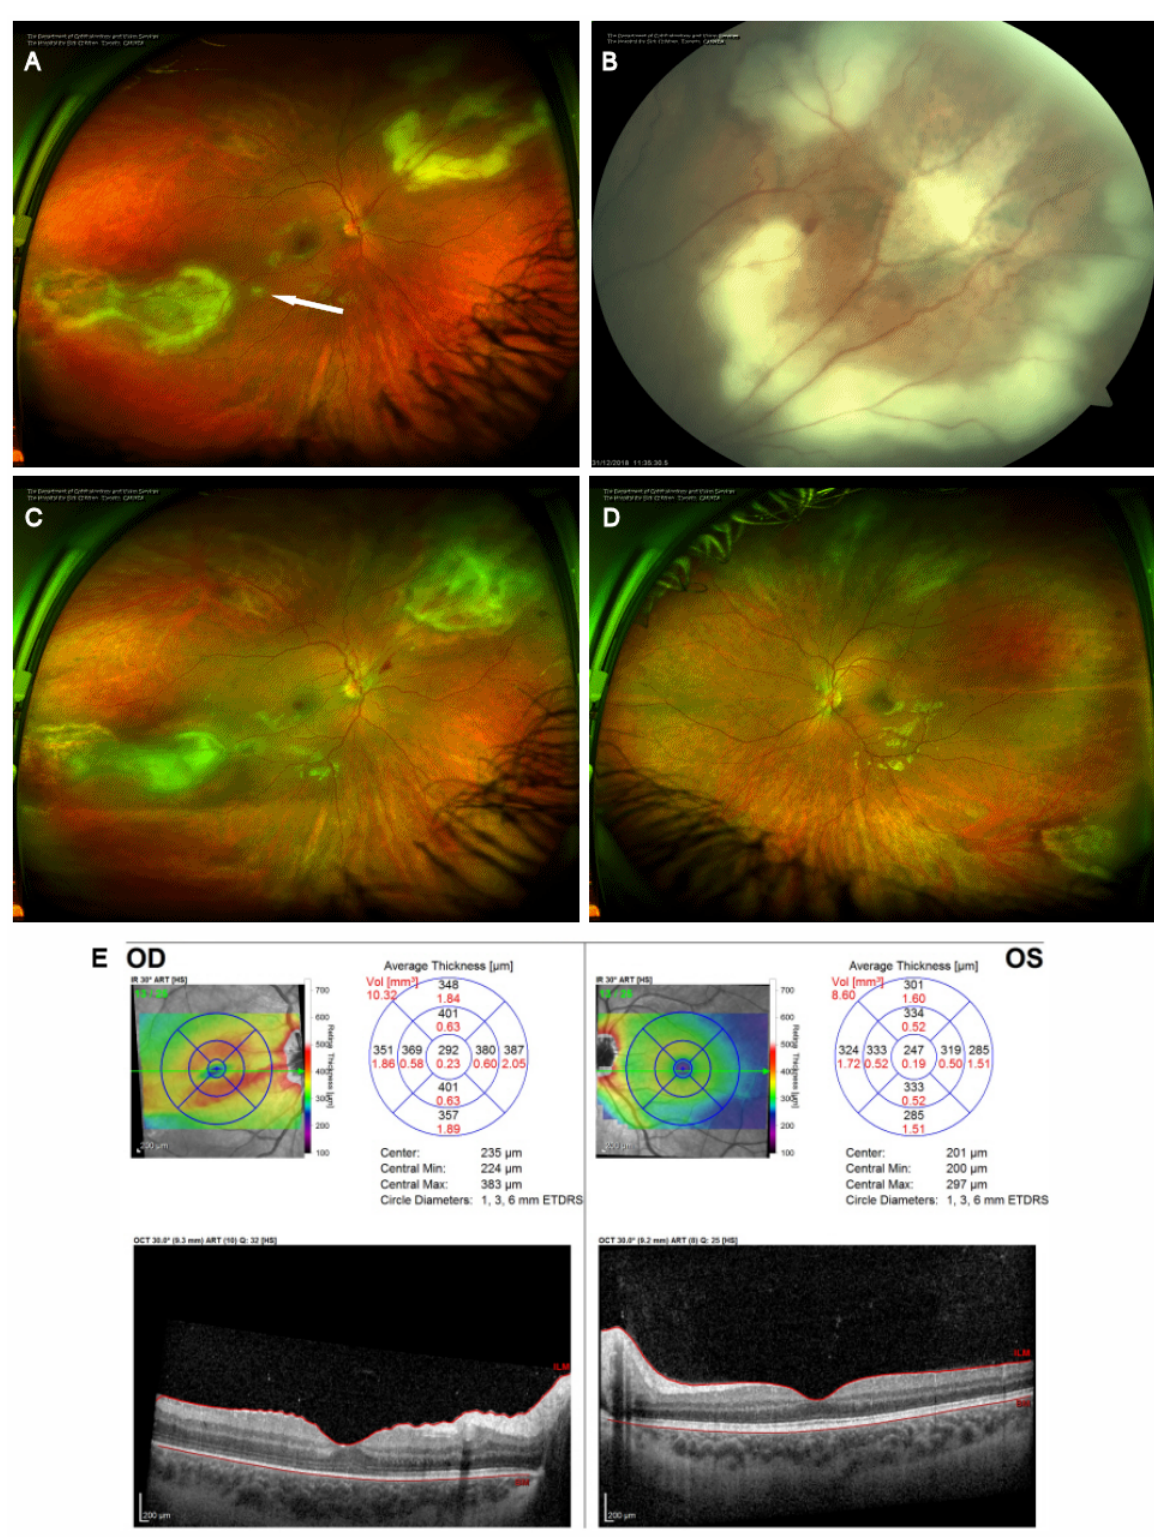
Figure 3: Progression despite treatment. (A) Optos ultra-widefield photography of the right fundus four weeks after the initial presentation demonstrating both supranasal and infratemporal areas of retinitis with a magnified view of the superonasal lesion demonstrating a progression of the retinitis (B). The arrow in (A) denotes a new satellite area of retinitis. (C) Optos ultra-widefield photography of the right eye and (D) left eye demonstrating the early response to the first round of intra-vitreal clindamycin and foscarnet with the lesion margins beginning to show healing. (E) OCT analysis of the macula demonstrating thickening of the nasal macula in the right eye with distortion of the architecture of the retina. The left eye remains normal.